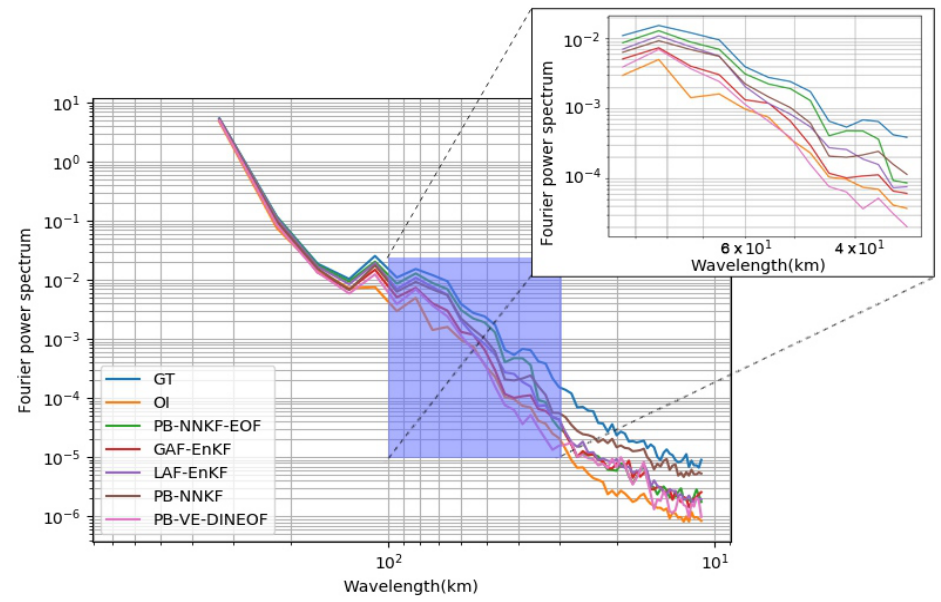
Figure 5. Radially averaged power spectral density of the interpolated SST fields with respect to the reference